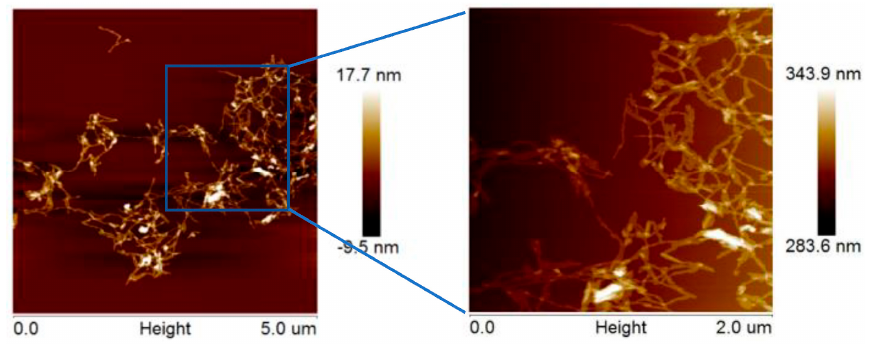
Figure 4. AFM images of CNCs extracted via swelling − SA − catalyzed hydrolysis process.